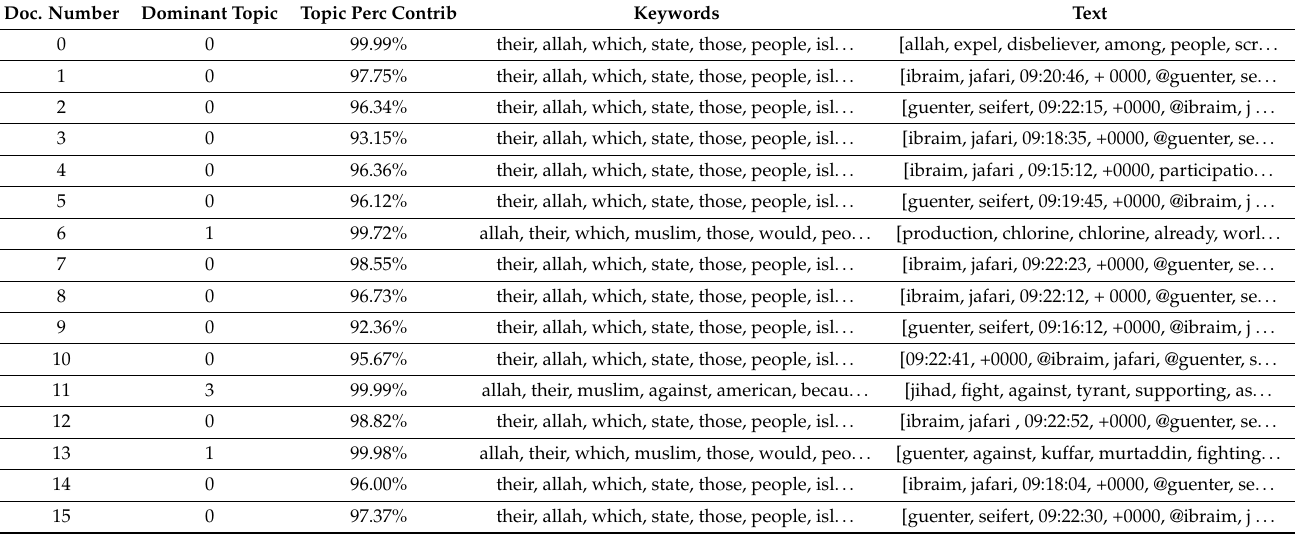
Table 4. Dominant topic per document in the text sample introduced in Section